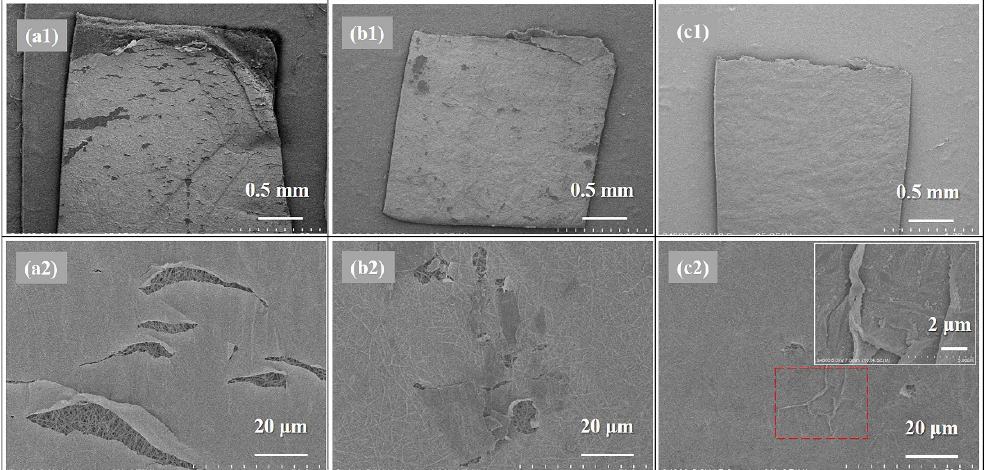
Figure 9. SEM images of the damaged nanofiber TFC FO membranes: ( a1 , a2 ) n-TFC; ( b1 , b2 ) o-TFC; ( c1 , c2 ) w-TFC (inserted image: magnification of “wrinkle” in rectangle with a red dotted line).